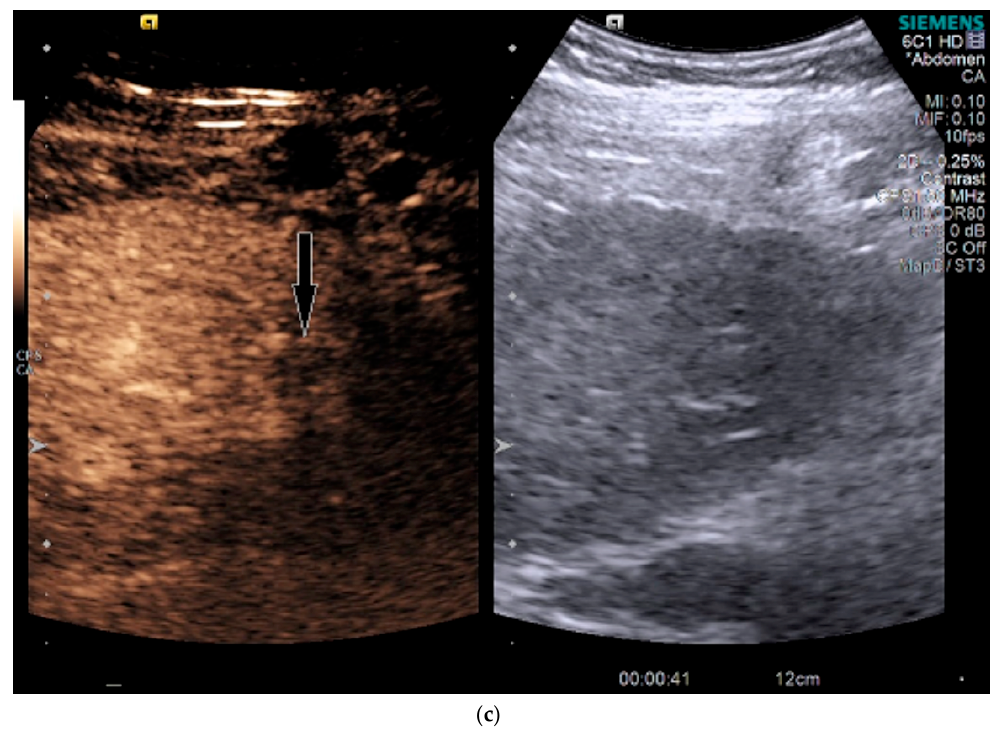
Figure 3. Patient 2 ultrasound images, with liver lesion denoted by black arrow: ( a ) grayscale images showing the hypoechoic lesion. Post contrast administration ultrasound in arterial phase ( b ) and early washout ( c ) of the lesion, LI-RADS M.